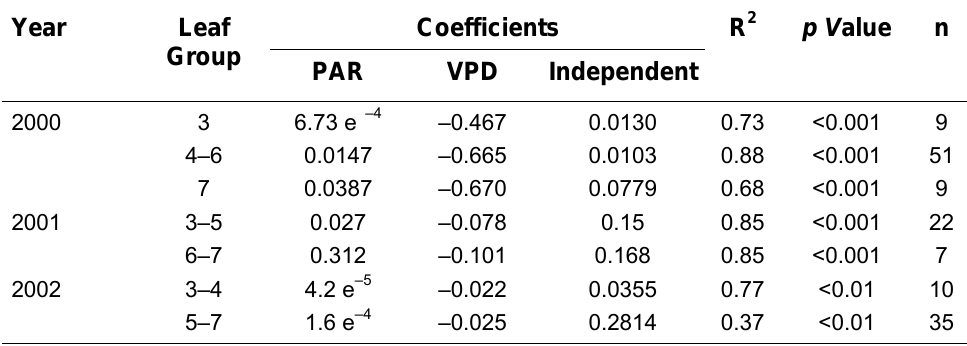
Multiple Regressions for g